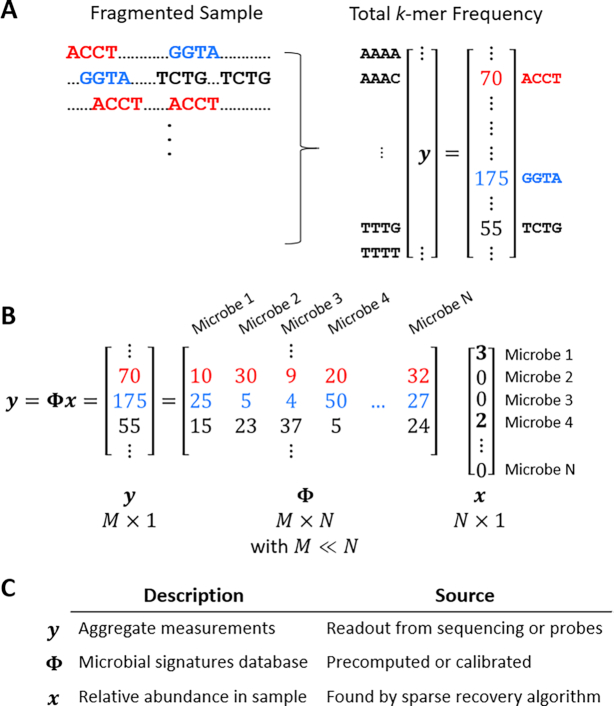
Example of CS for microbial quantification. (A) A nucleic acid sample is fragmented, and the k-mer frequency is calculated from sequencing data or inferred from probe binding events. M represents the number of k-mers chosen for analysis; in this simple example, all possible 4-mers are quantified for 44 or 256 measurements. (B) Metagenomic samples contain nucleic acids from many microbes, so the measurement vector y represents a linear combination of underlying microbial quantities. Microbial signature k-mer frequencies are stored in N columns of a sensing matrix Φ in advance. Given Φ and having measured y, the goal of CS is to solve for x, the microbial quantities in the sample. To constrain the solution, CS assumes that the number of unique microbes in any given sample is far fewer than the N known microbes in the database, i.e. that x is sparse with many zero entries. Here, y is explained by a sparse combination of Microbes 1 and 4. (C) Summary of CS variables in the context of this application.